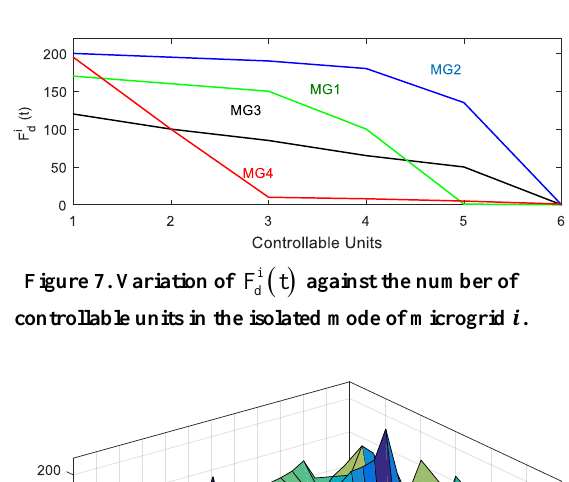
Figure 4. Schematic representation of Multi-microgrid system with its components. Table 1. Location of energy resources. Energy